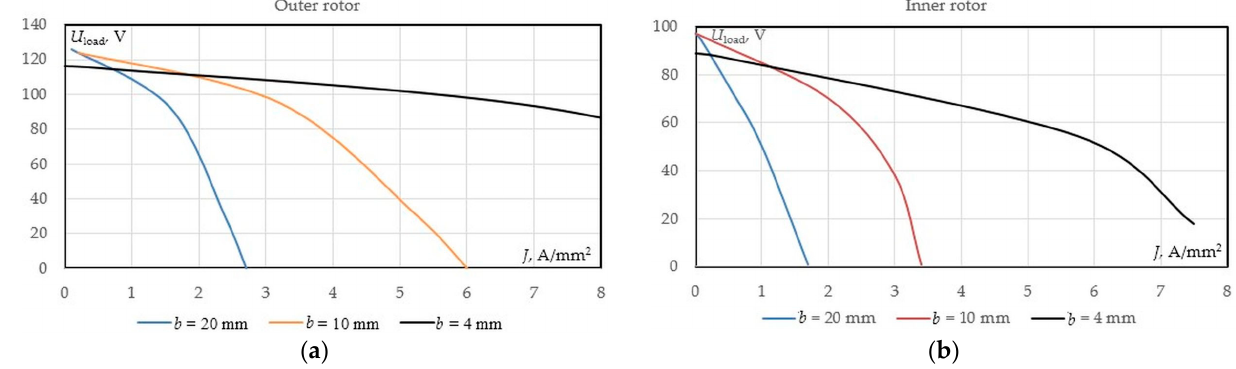
Figure 12. Terminal voltage characteristics of the outer and inner rotor TFM models with different coil heights: ( a ) TFM with an outer rotor and ( b ) TFM with an inner rotor.